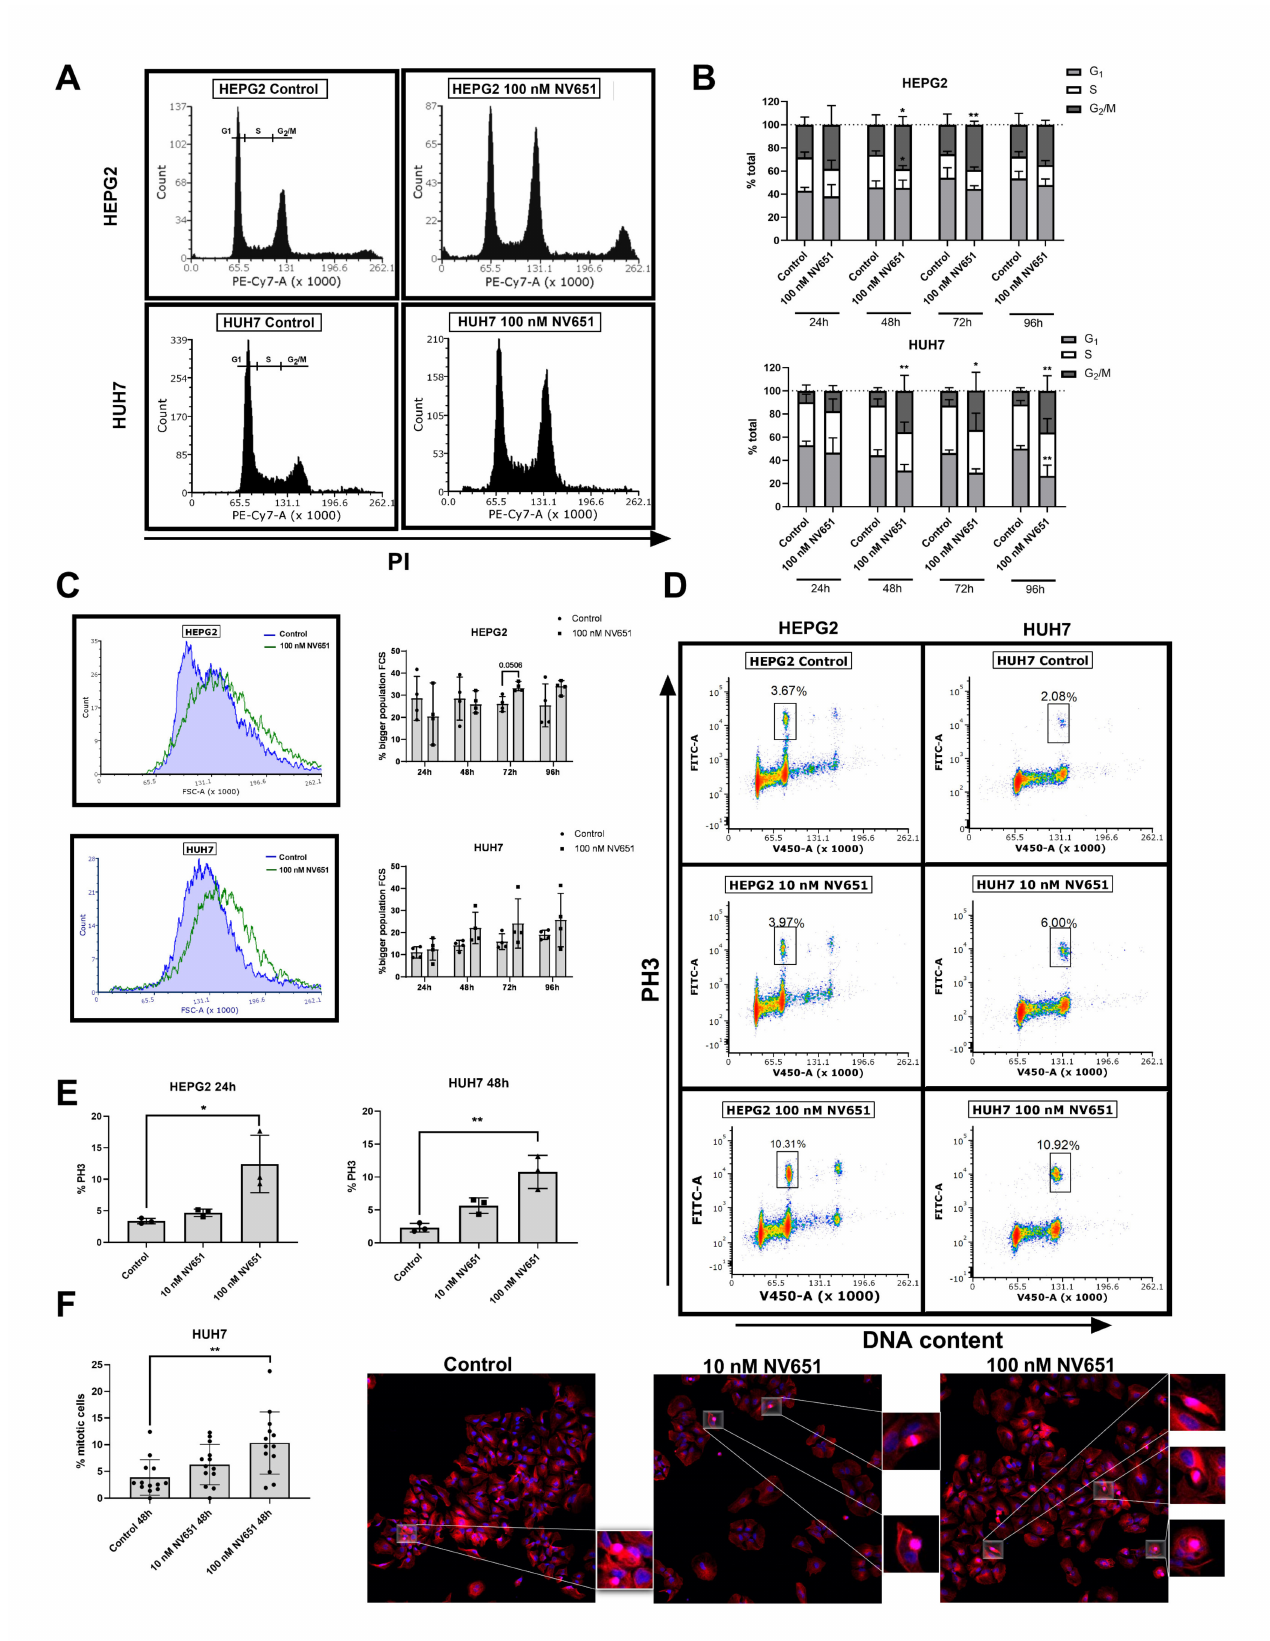
Figure 6. NV651 effect in the cell cycle. ( A , B ) DNA content analyzed with PI staining in HEPG2 and HUH7 treated with DMSO or 100 nM of NV651. ( A ) Representative histograms of HEPG2 at 24 h of exposure and HUH7 at 96 h. ( B ) G 1 , S and G 2 /M quantification at 24, 48, 72 and 96 h of NV651 treatment. ( C ) To the left, representative histograms of the